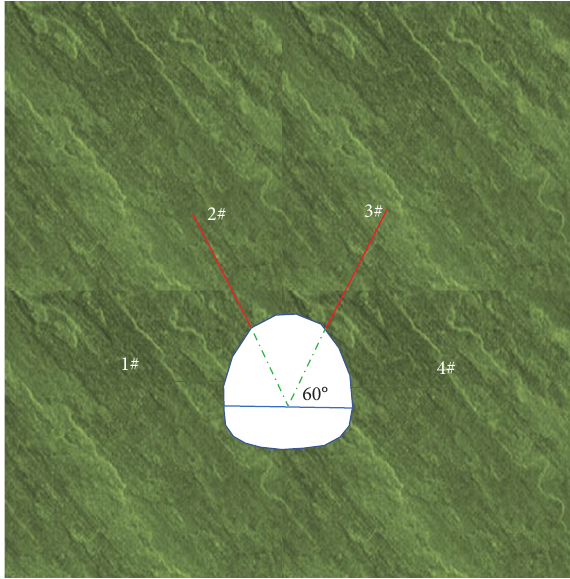
Figure 7: Layout of acoustic measuring hole.